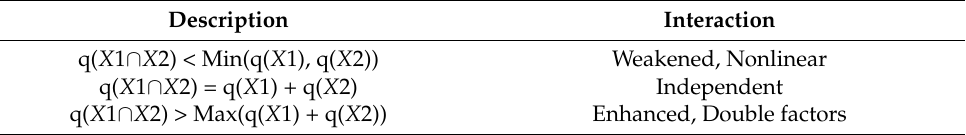
Table 2. Types of interaction between two